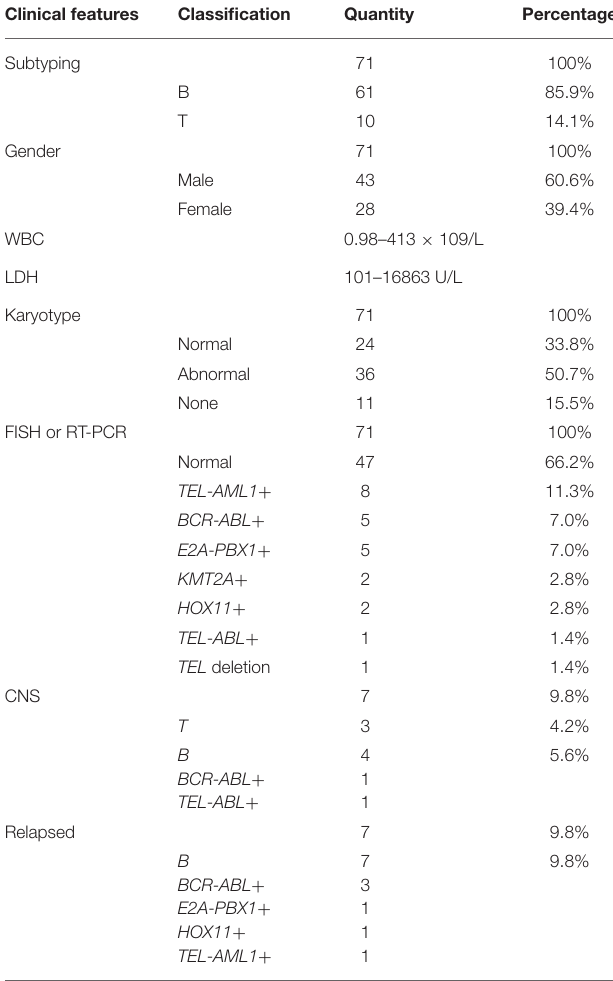
TABLE 1 | Clinical feature of the 71